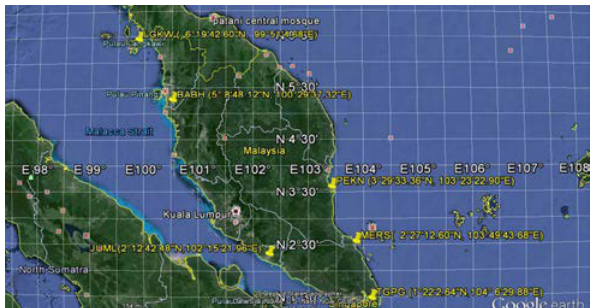
Figure 4. MyRTKnet receiver stations network (yellow pins) in Peninsular Malaysia used in this